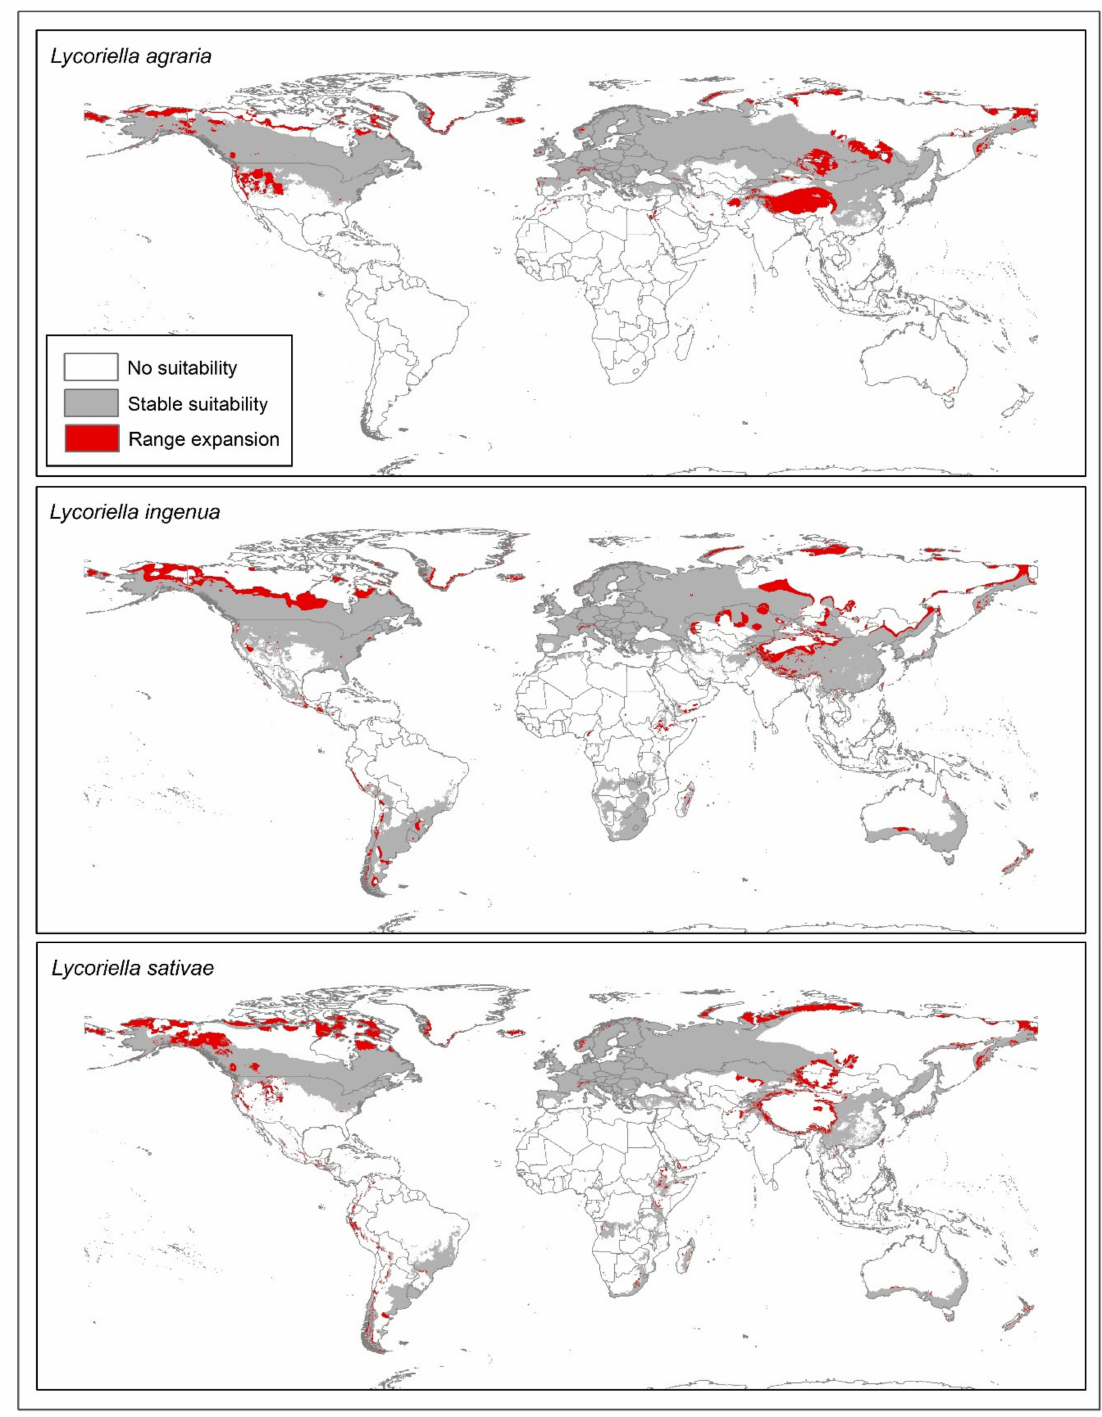
Figure 1. Potential distribution of three Lycoriella species under present and future climate conditions under two emissions scenarios (RCP 4.5 and RCP 8.5). Models show potential for range expansion worldwide in areas with low extrapolation